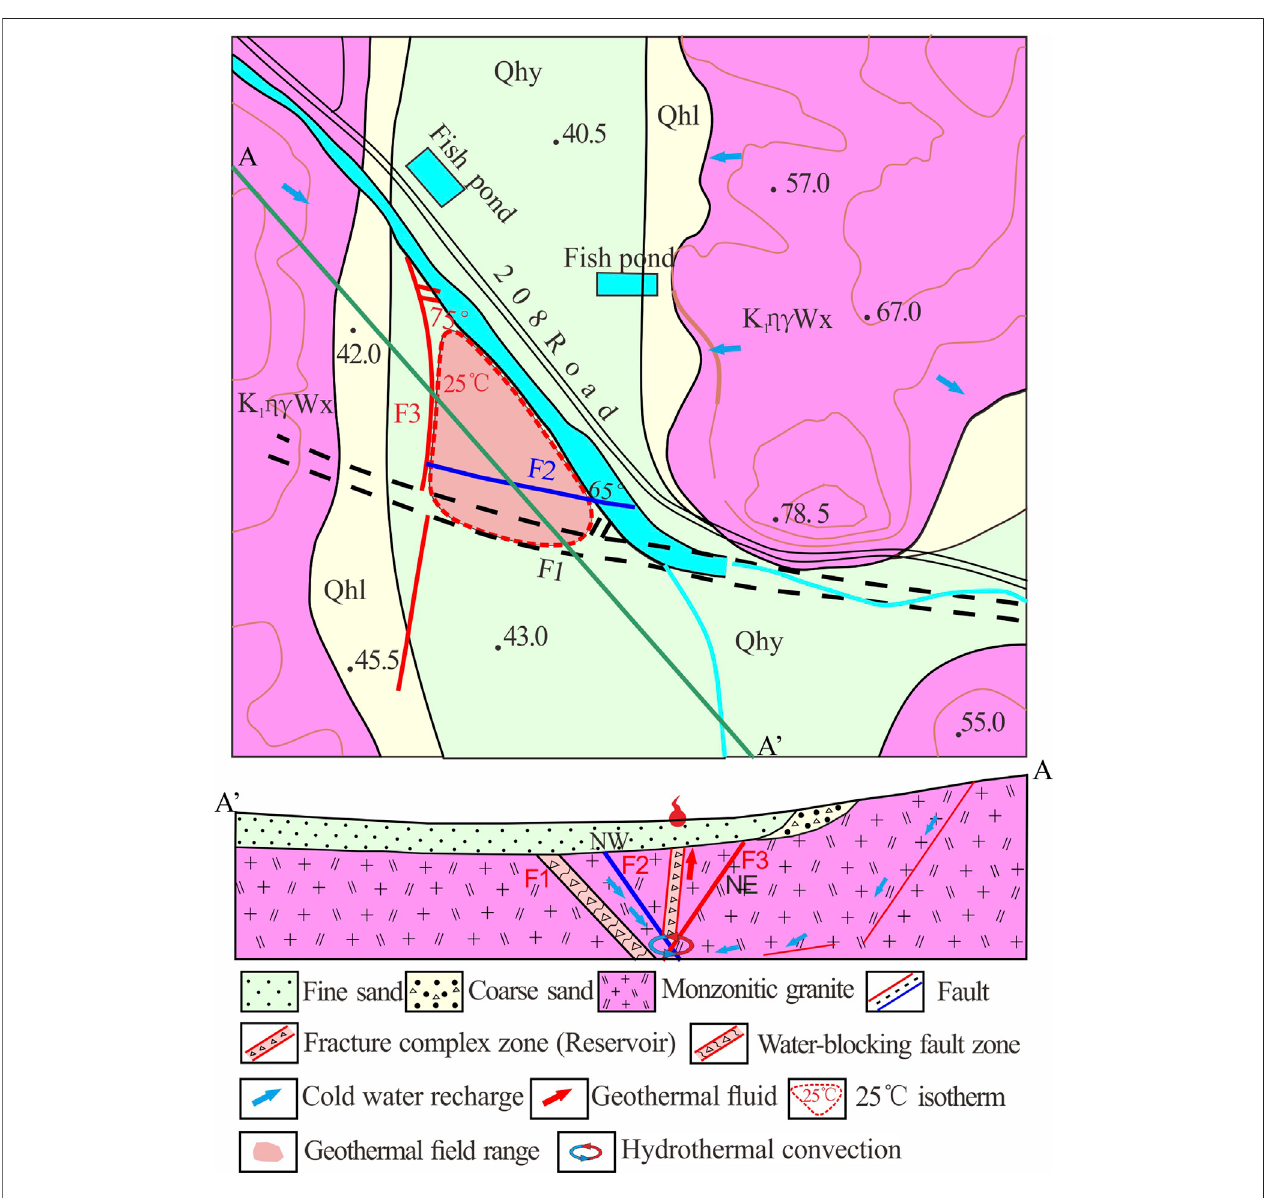
FIGURE 4 | Geologic map of the Yujia hot spring area and pro fi le of the geothermal fi eld.